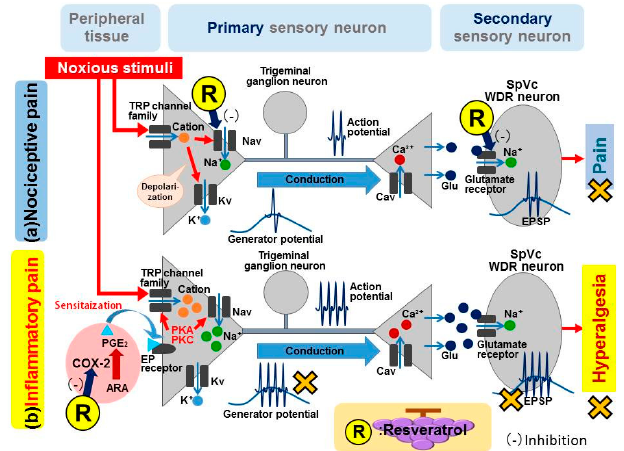
Figure 1. Schematic drawing of the possible mechanism underlying the effects of resveratrol in relieving ( a ) nociceptive and ( b ) inflammatory pain. ( a ) nociceptive pain. When noxious mechanical stimulation is applied to the skin, mechanosensitive ion channels (e.g., transient receptor potential ankyrin 1 (TRPA1) channels) open, activating the generator potential (depolarization). This depolarization further opens voltage-dependent sodium and potassium channels, generating action potentials.